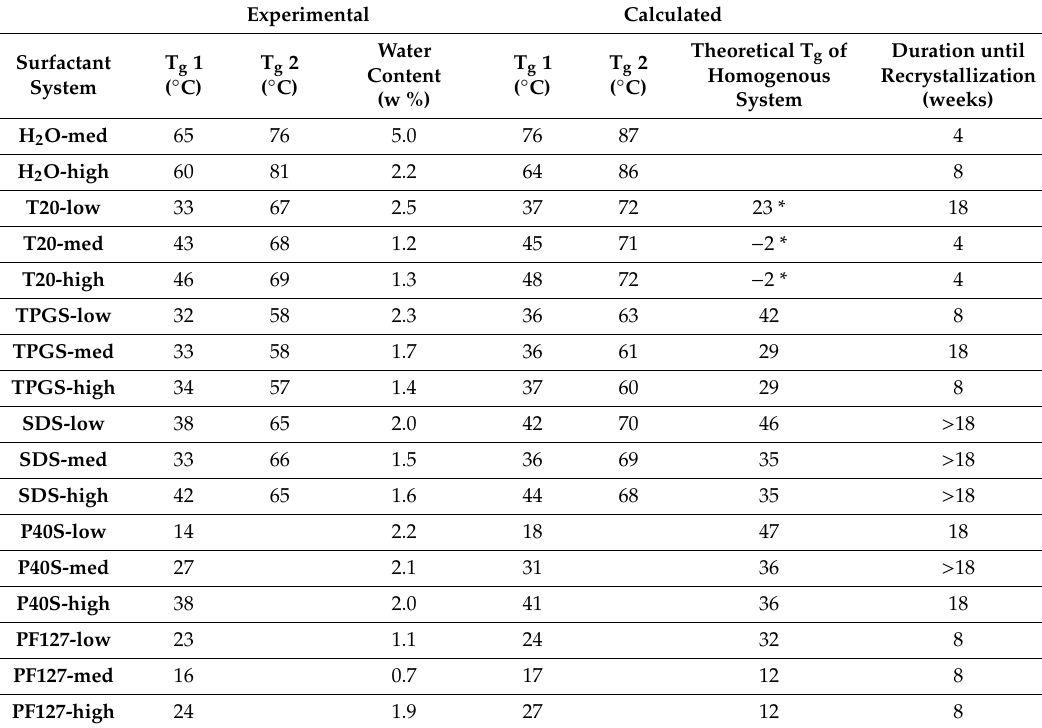
Table 3. Experimentally determined T g s for naproxen-arginine (NAP-ARG) co-amorphous systems and water content of the systems. Re-calculated T g for the systems without water, theoretical T g for a homogenous system and storage stability as duration until first recrystallization. Calculated values for Tween 20 systems marked with * must be regarded as